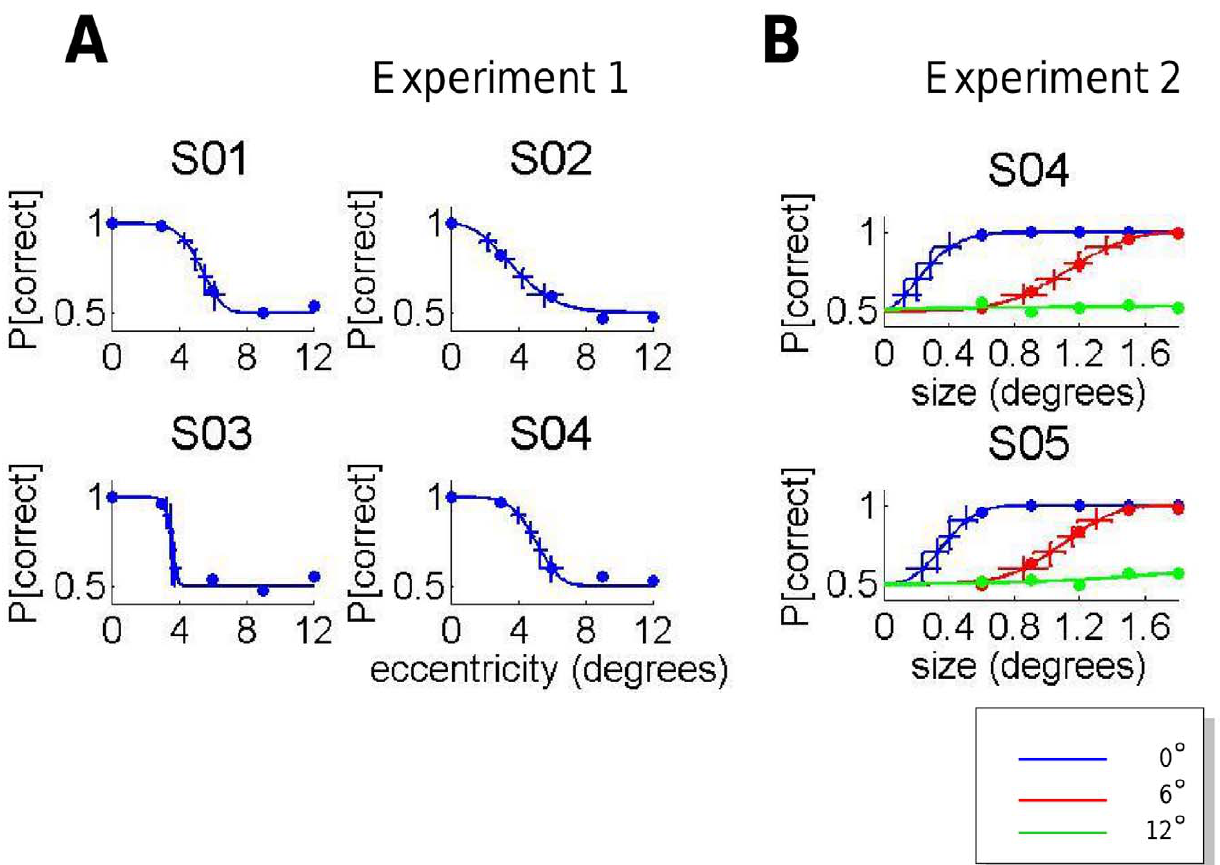
Figure 4. Retinal sensitivity mapping. A. Experiment 1. The observer’s probability of correctly identify the stimulus configuration (dot-up or dot- down) is plotted as a function of the eccentricity at which the configuration was presented. Data is presented for all five observers. The smooth curve is a maximum likelihood fit of a psychometric function. The observer’s probability of correctly identify the stimulus configuration (dot-up or dot- down) is plotted as a function of the stimulus size for stimuli presented at each of three retinal eccentricities. B. Experiment 2. Data is presented for both observers. Observer S04 in Experiment 2 was the same observer as Observer S04 in Experiment 1. See text.